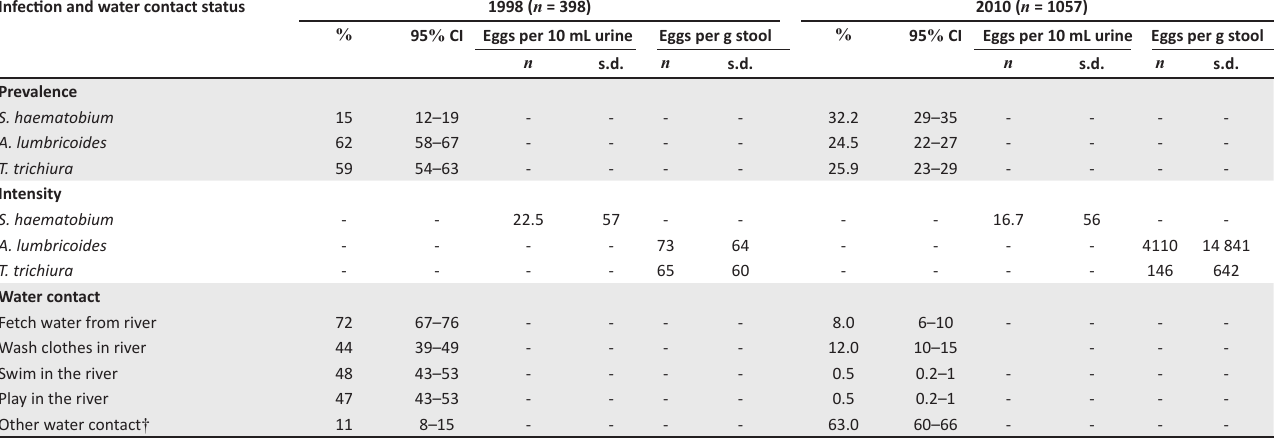
TABLE 6: Comparison of prevalence and intensity of helminth infections and water contact in 1998 and 2010 studies in Ugu district. 20 Infection and water contact